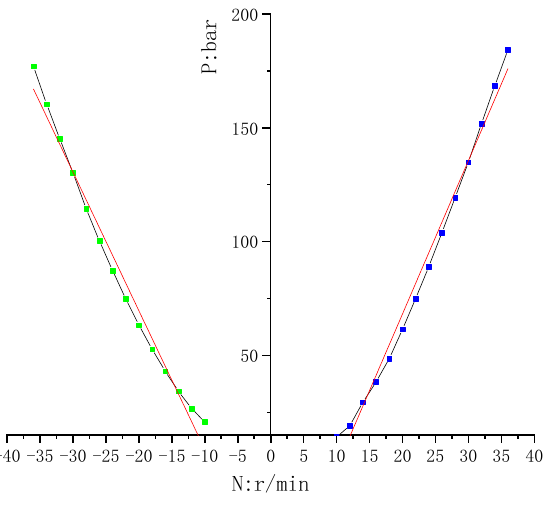
Figure 9. Dead zone pressure test data graph.